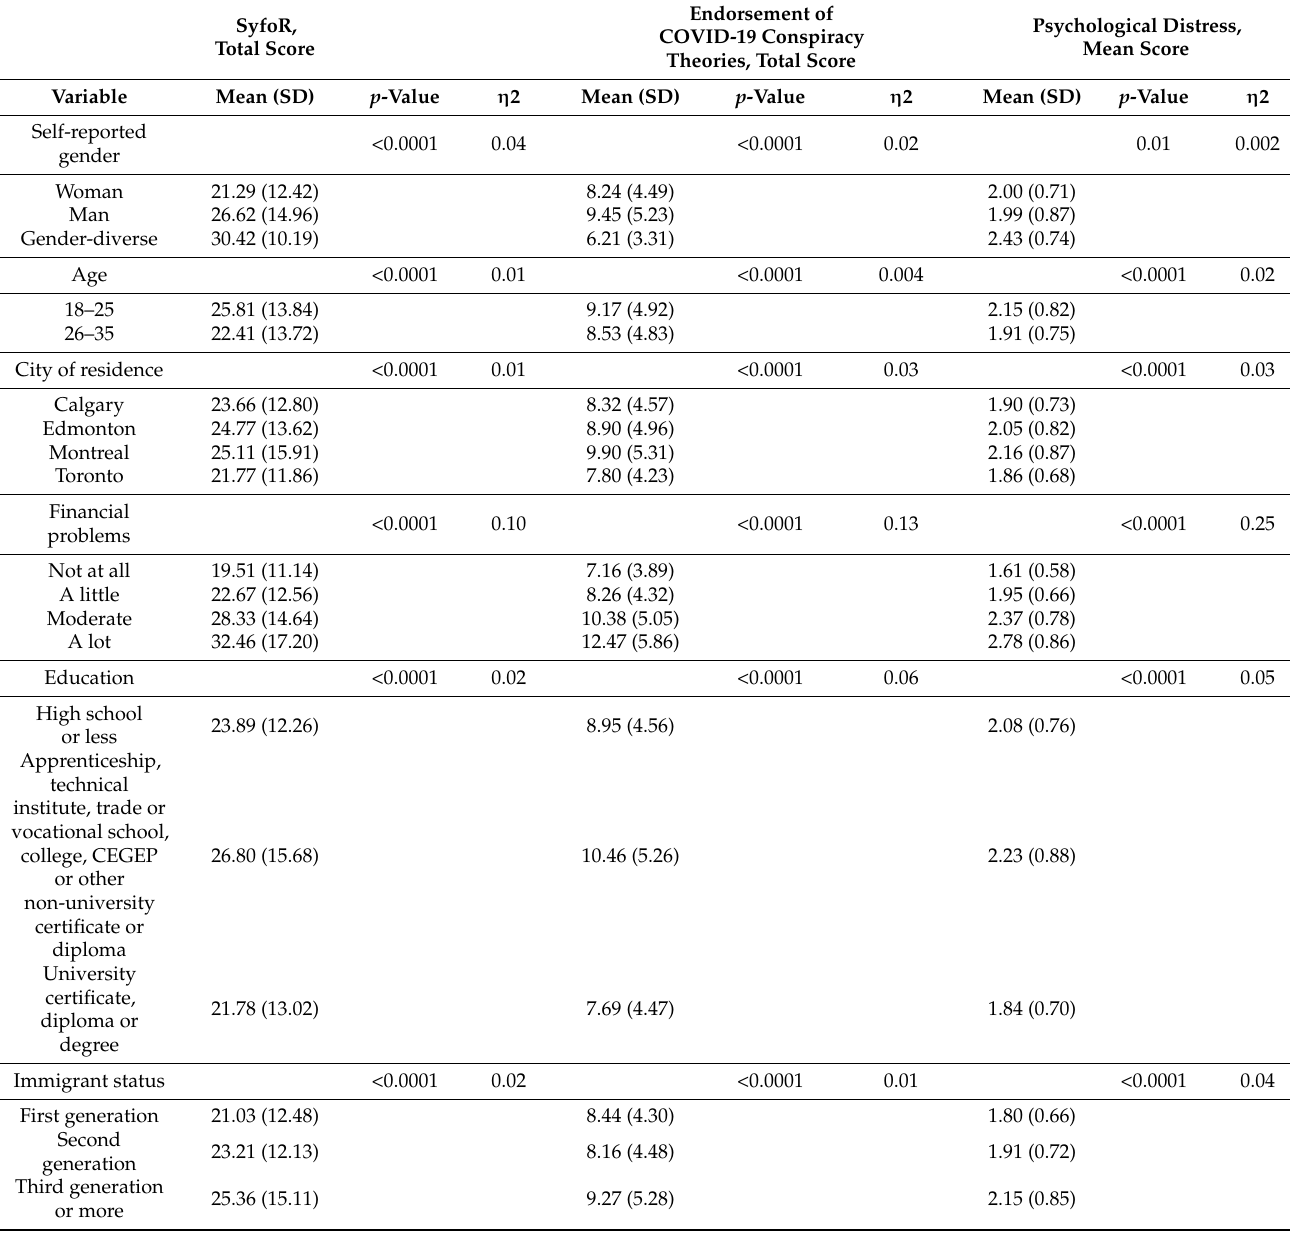
Table 2. Descriptive statistics of study variables: SyfoR, endorsement of COVID-19 conspiracy theories and psychologi- cal